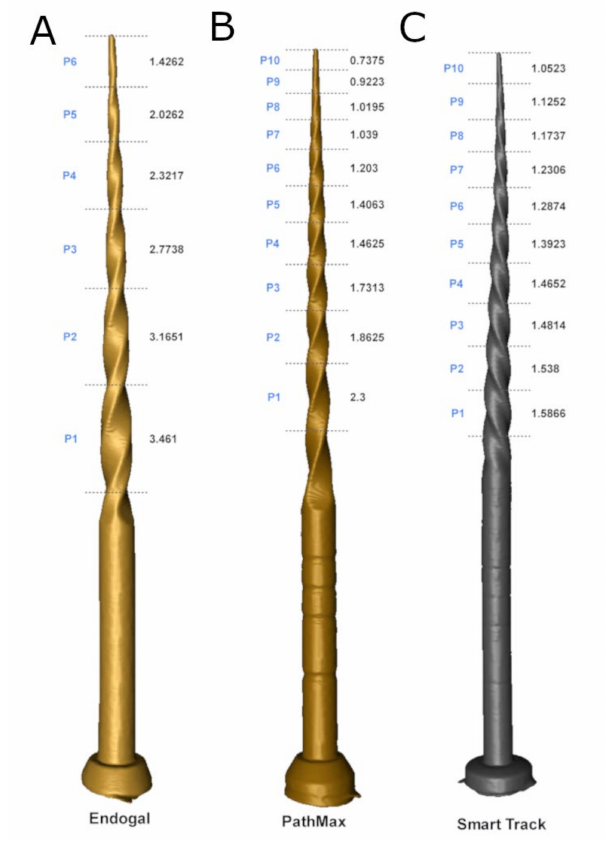
Figure 5. ( A ) STL digital files of EDG NiTi alloy endodontic rotary file, ( B ) PMP heat-treated NiTi alloy endodontic rotary file, and ( C ) ST heat-treated NiTi alloy endodontic reciprocating